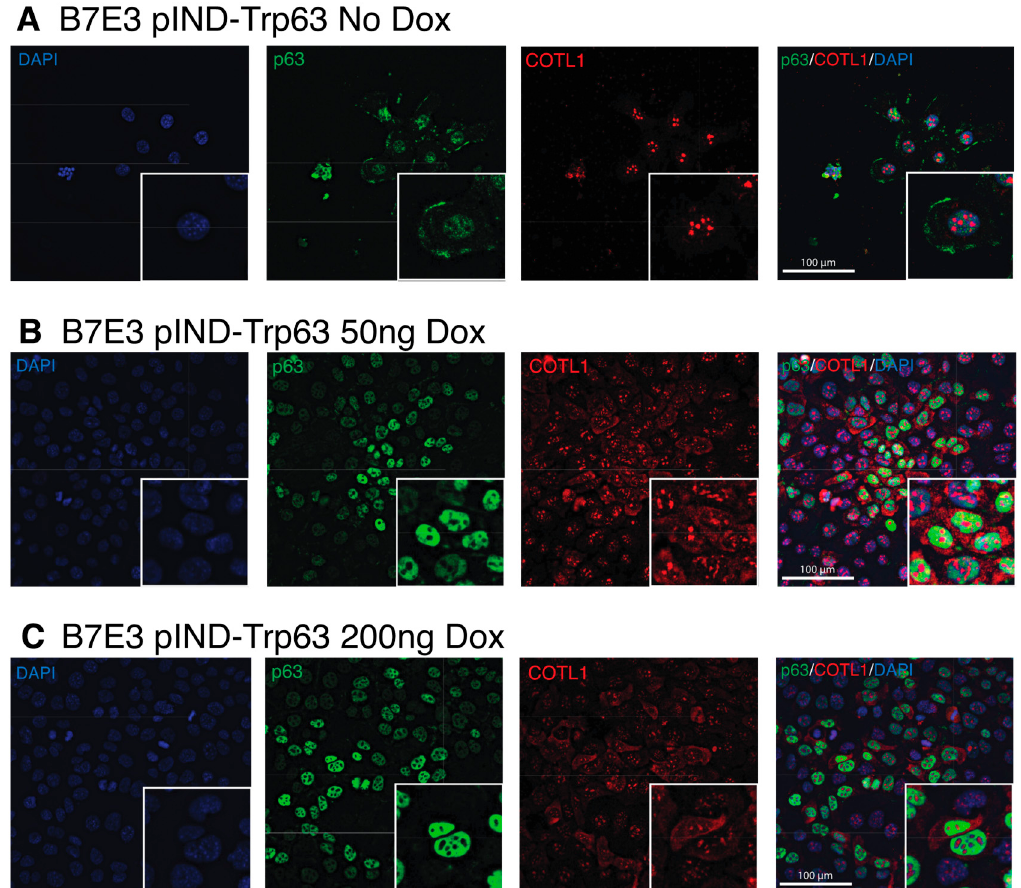
Figure 9. Co-staining of p63 and COTL1 in B7E3 cells with induced p63 expression. Immunofluo- rescence images of p63 (green), COTL1 (red), and DAPI (blue) in B7E3 cells treated with no dox ( A ), 50 ng dox ( B ), or 200 ng dox ( C ).